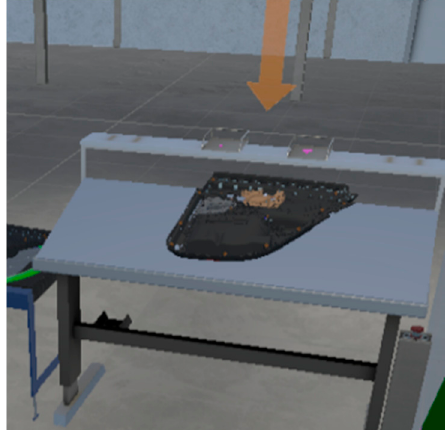
Figure 7. Example of workplace before rationalisation